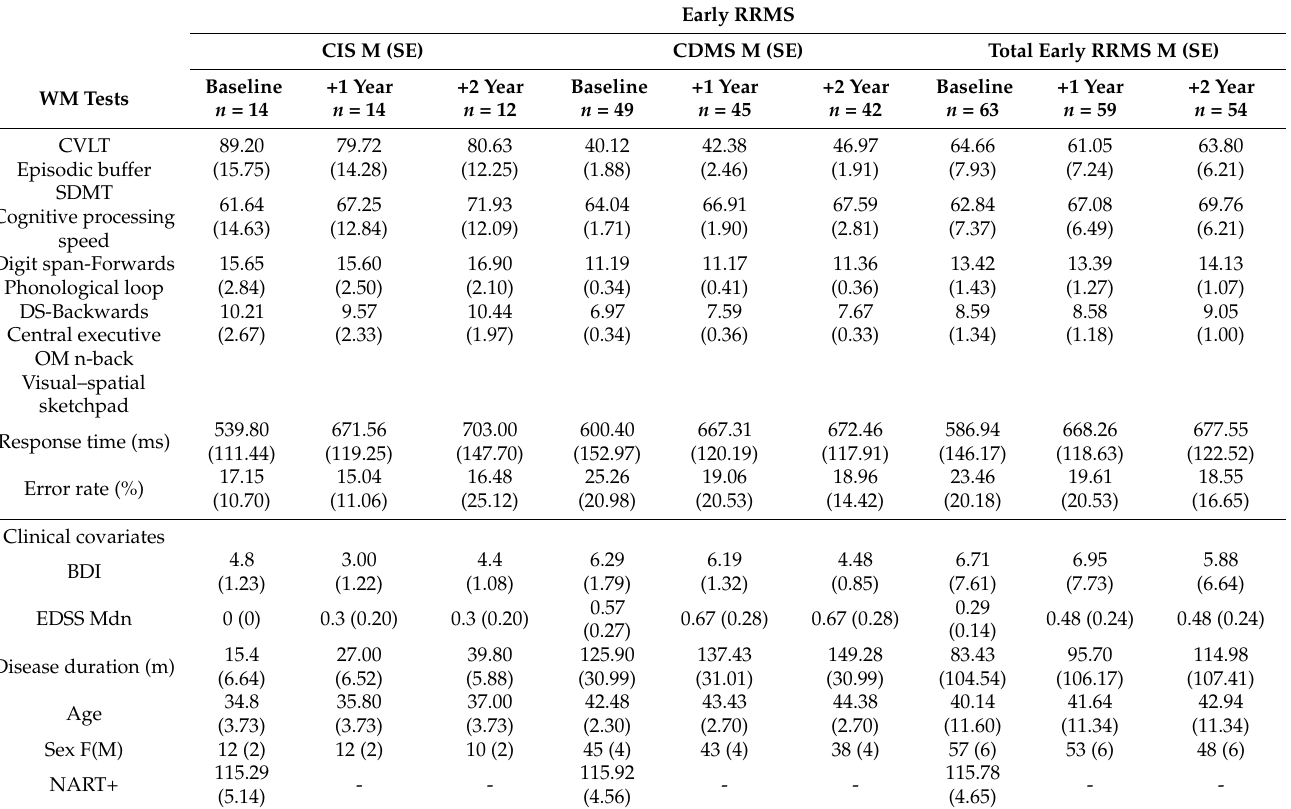
Table 4. Adjusted averages for WM subcomponent tests and clinical covariates across the study